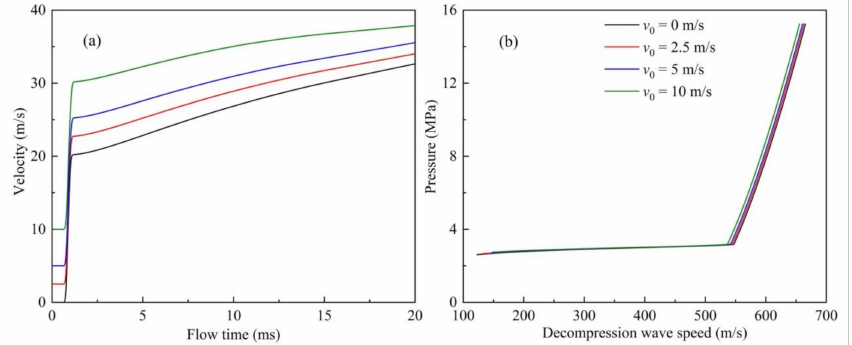
Figure 8. Effects of flow velocity on ( a ) local outflow velocity and ( b ) decompression wave